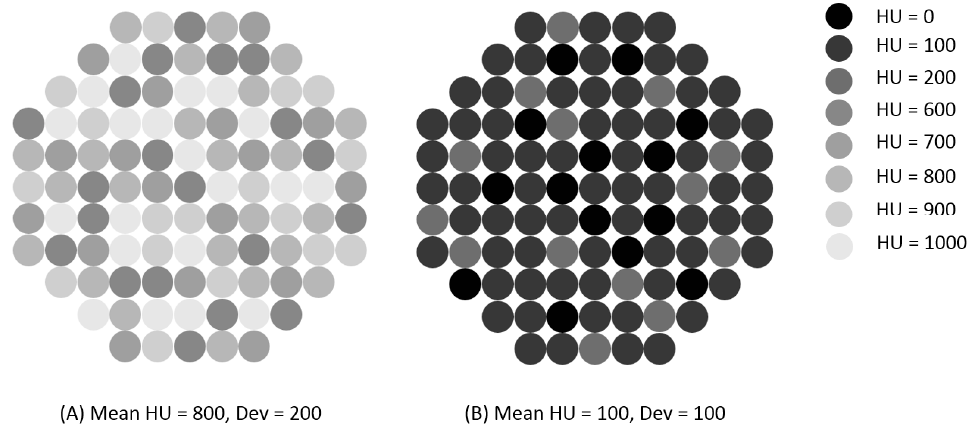
Figure 2. Schematic pictures showing the mean Hounsfield units (HUs) and deviation (Dev) of a lesion on CT scan. ( A ) demonstrates a lesion with a high HU and high Dev. ( B ) demonstrates a lesion with low HU and low Dev. Table 4. Prediction based on HU and deviation